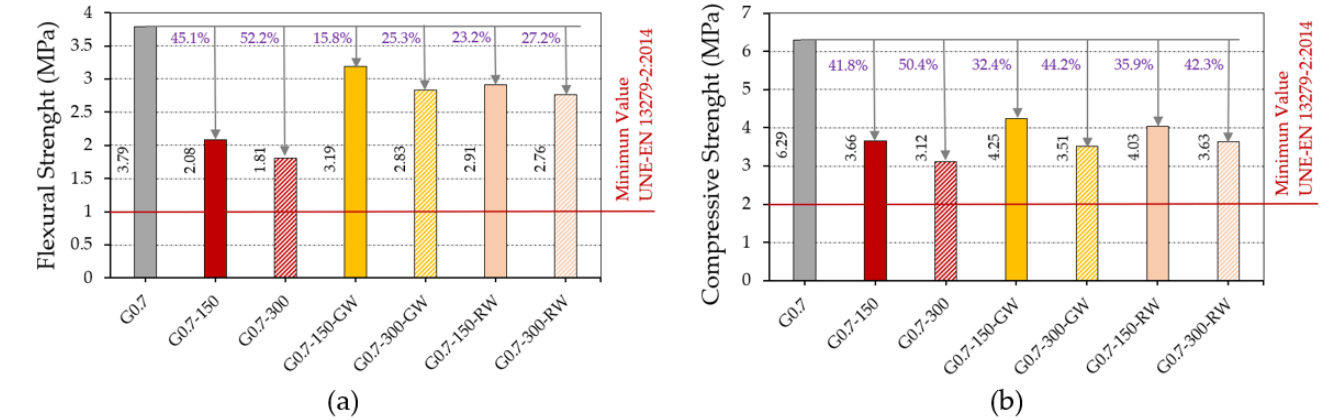
Figure 9. Results of the mechanical characterisation of gypsum composites: ( a ) flexural strength and ( b ) compressive strength.